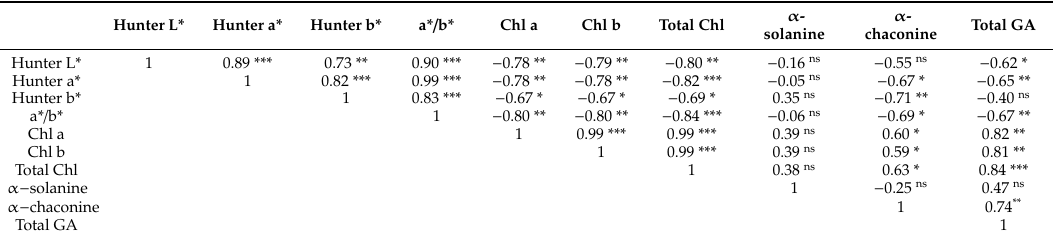
Table 2. Correlation between color values, Chls, and GA contents of ‘Atlantic’ and ‘Trent’ potato cultivars under six greening stages during storage at room conditions (22 ◦ C) with a 12-h shift of light-dark